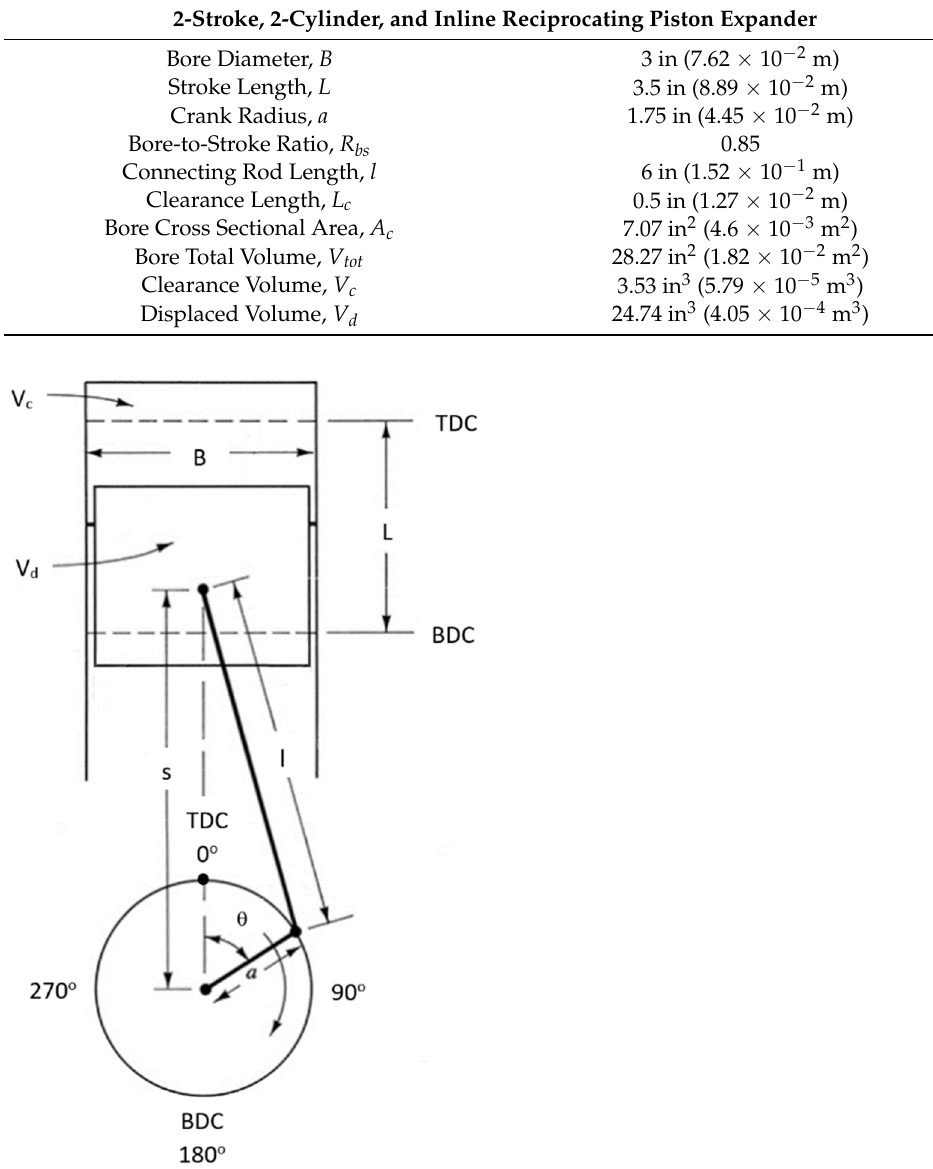
Figure 5. Geometric model of the engine. Table 1. sCO 2 engine parameters.